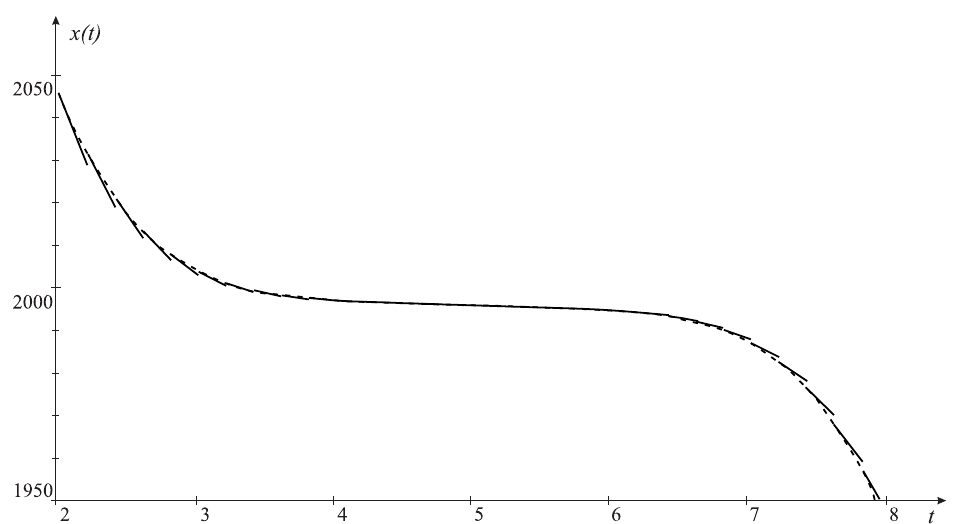
Figure 4. Graphs of the function x ( t ) with a dotted line and forecast curves with solid lines on the segment [ 2,8 ]